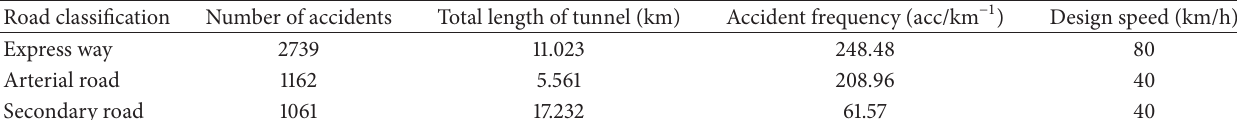
Table 2: City road classifications and traffic accidents.